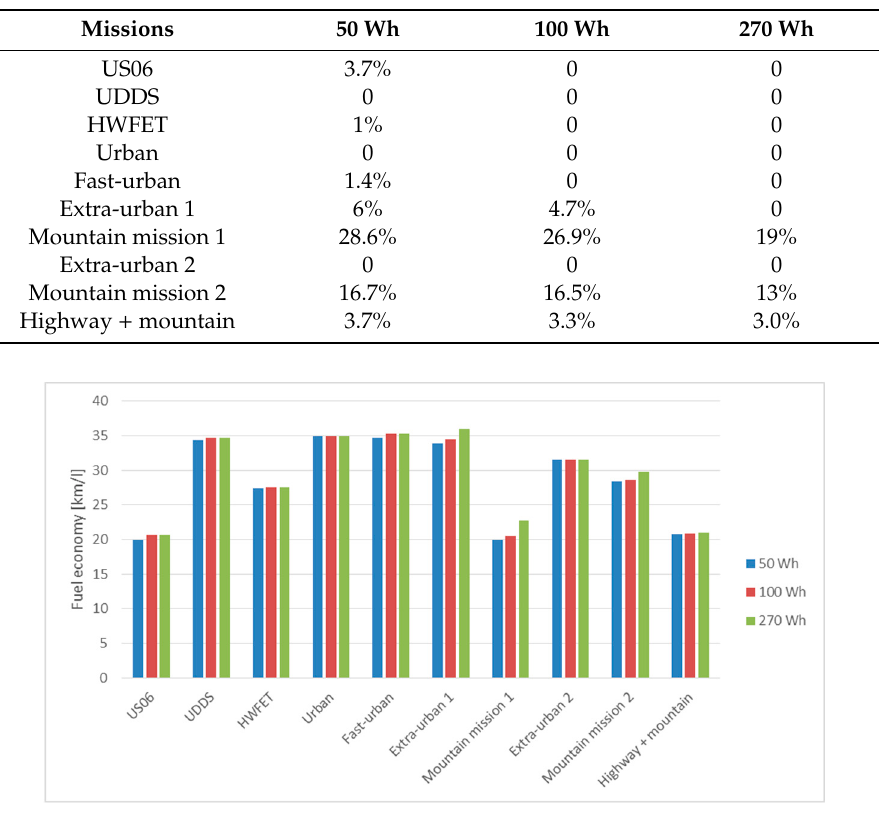
Table 6. Wasted energy on mechanical braking as a percentage of energy provided by generator, for various Braking Zone (BZ) sizing.